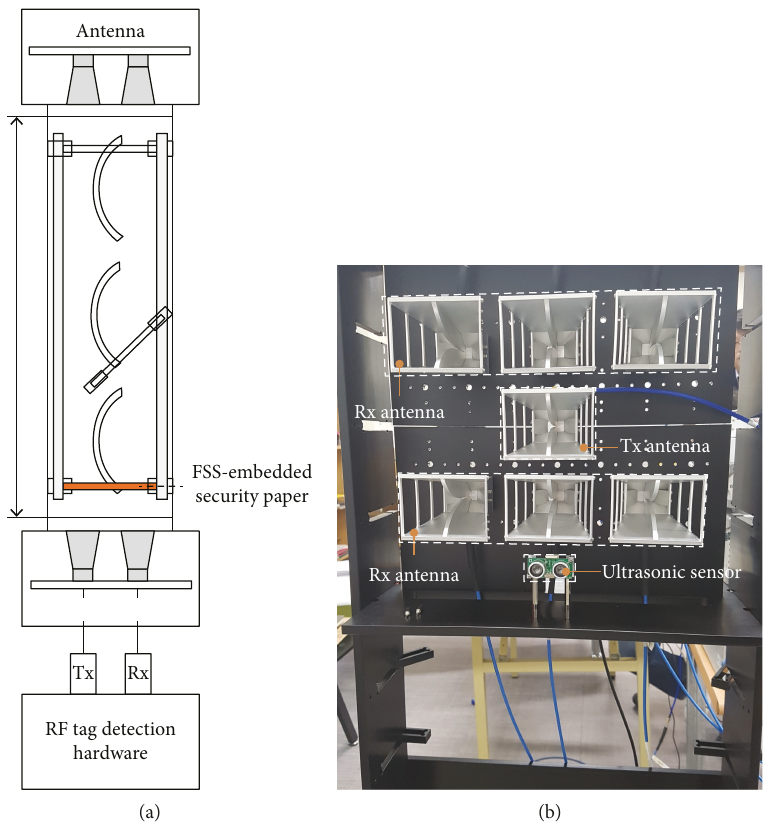
Figure 5: Security paper detection system setup: (a) security paper detection system setup (top view); (b) fabricated security paper detection antenna setup.